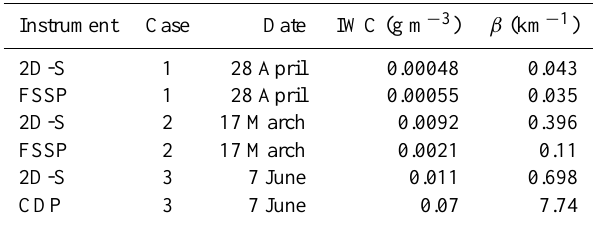
Table 2. Table shows in-situ estimates of IWC and extinction coef- ficient β from each 2D-S, FSSP, and CDP instruments for 17 March, 28 April, and 7 June thin cirrus test cases.